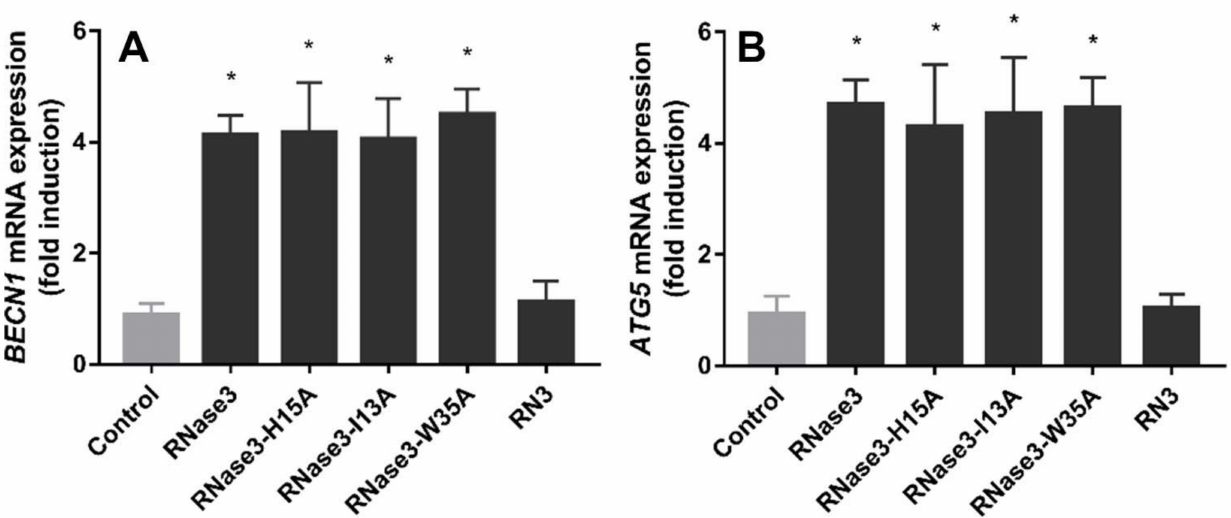
Figure 7. RAW 264.7 macrophages were infected with M. aurum and treated with 10 µ M of protein or peptide (RNase 3, its mutants I13A, H15A and W35A, and the peptide RN3(1-45)) for 24 h. Real- time qPCR measured the relative expression of BECN1 ( A ) and ATG5 ( B ) genes, normalized by housekeeping gene β -actin . Results are shown from three independent experiments (mean ± SD). * indicates significant difference compared with control group ( p < 0.05). RNase 3-H15A data are taken from